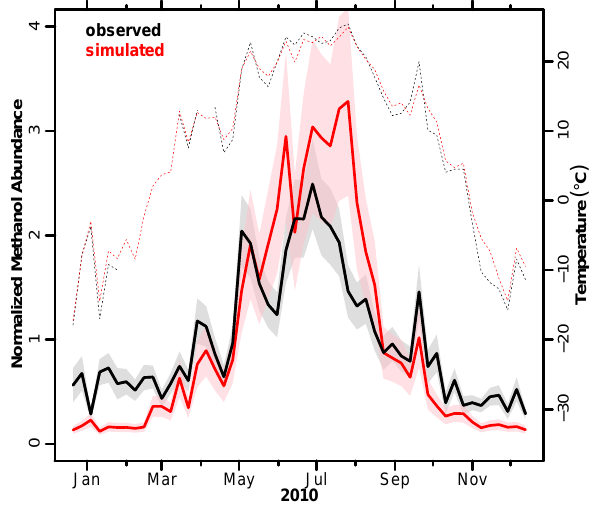
Fig. 4. Seasonality of atmospheric methanol abundance in the US Upper Midwest. Weekly medians (normalized to the annual aver- age) observed at the KCMP tall tower (solid black line) are com- pared to the corresponding values simulated by GEOS-Chem (solid red line). Shaded areas show the 95% confidence intervals. Dashed lines show the weekly median air temperatures measured at the site (black) and the assimilated values used to drive GEOS-Chem